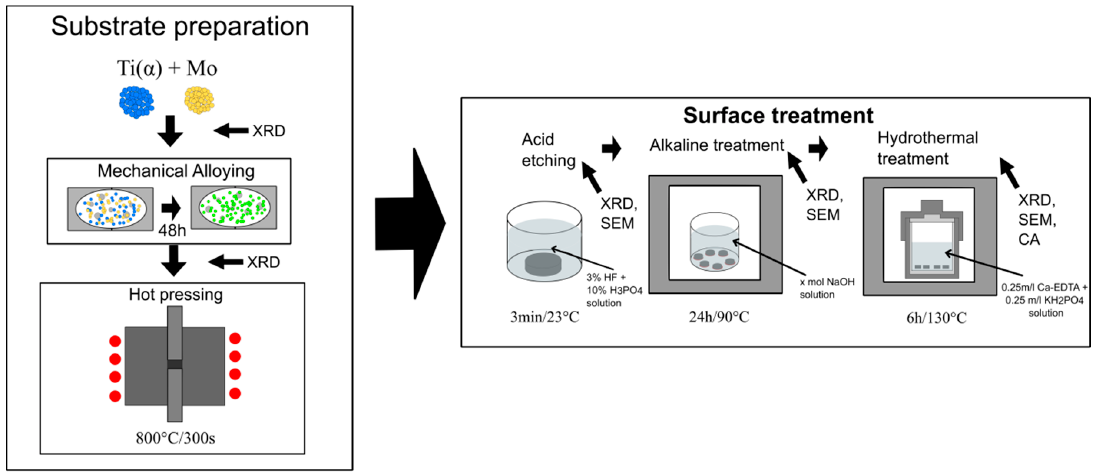
Figure 1. Schematic process illustration.